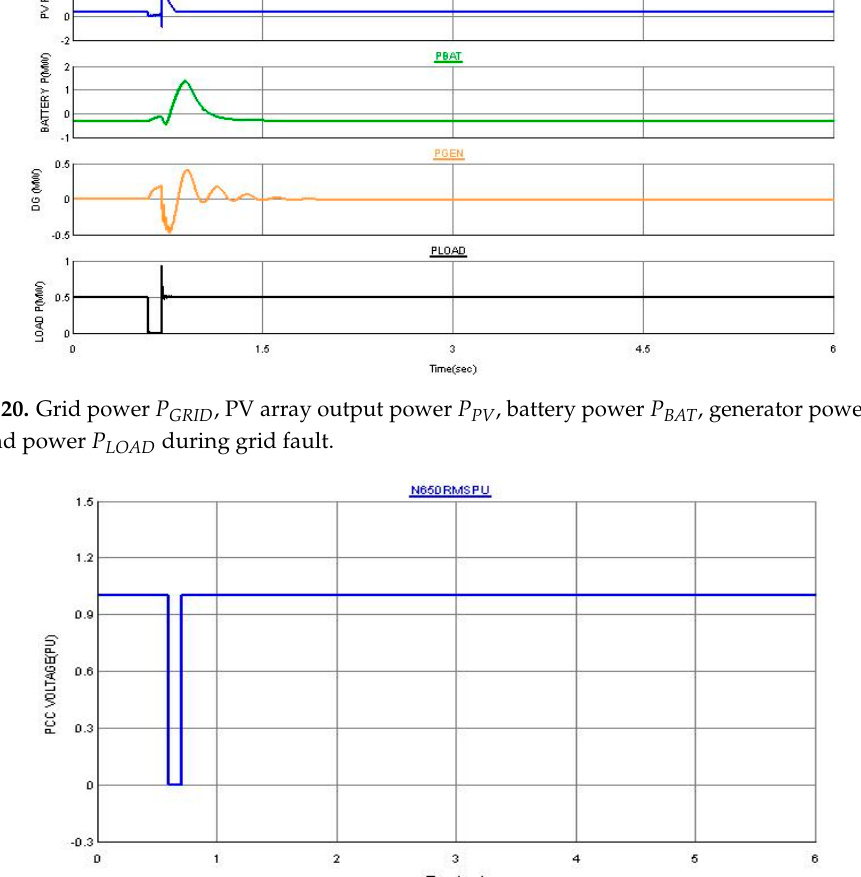
Figure 22. Grid power P GRID , PV array output power P PV , battery power P BAT , generator power P GEN and load power P LOAD during island fault. 5. Conclusions An efficient power management control scheme of a microgrid based on PV, battery, diesel generator and load was presented in this paper. An independent P - Q controller is implemented to transfer the PV array and the battery powers to both the PCC and to the load. The incremental conductance based MPPT implemented forces the PV array to work at the maximum power. The system voltage and frequency are maintained at the rated value by the grid during grid connected mode and by the diesel generator in the island mode. The transient and steady state response of the microgrid for both grid-connected and islanded modes of operation have shown to give satisfactory performance. With energy storage, the fault ride-through capability of the system was improved. The results show that the proposed control scheme manages the load power during island and grid connected modes and improves the system reliability. Author Contributions: M.Y.W. and M.A.A. initiated the idea and designed the controller. M.A.H. and the other authors performed the simulation and discussion.